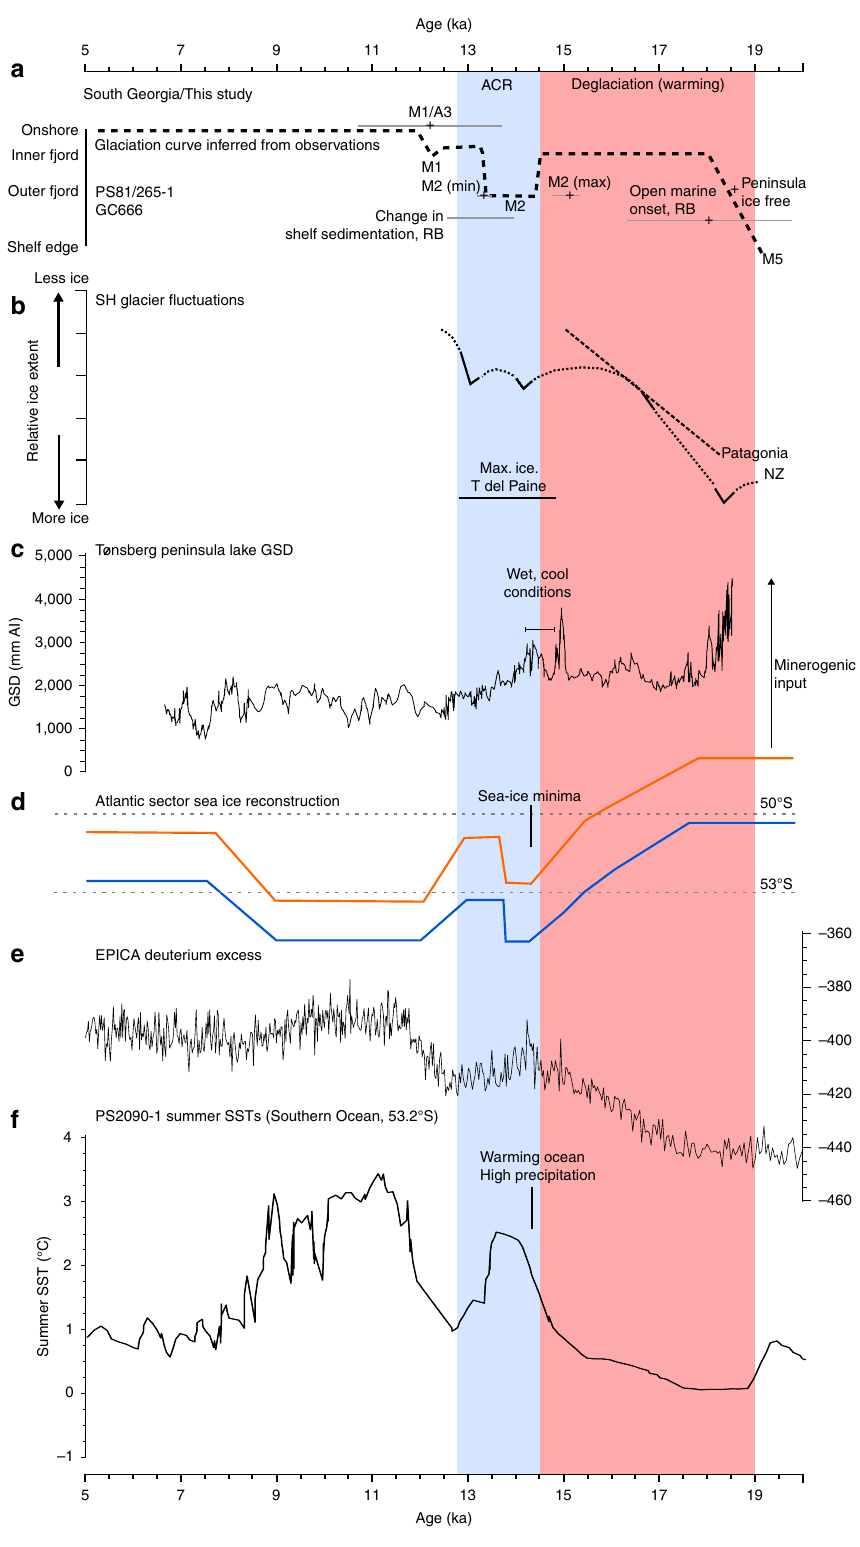
Figure 8 | South Georgia glacial history compared against published Southern Hemisphere glacial and climatic records. ( a ) Age constraints for events during the last deglaciation and termination on South Georgia from this study and published records, and a new glaciation curve inferred from these observations. These events are compared with ( b ) glacier fluctuations from other Southern Hemisphere sites (refs 28,34,73), ( c ) grey-scale density (GSD) record from Tønsberg Lake, north South Georgia, as a proxy for minerogenic input (ref. 25), ( d ) reconstructions of the northern sea-ice edge (blue line) and southern boundary of the polar front (orange line) for the last deglaciation in the Atlantic sector of the Southern Ocean (ref. 75), ( e ) EPICA Dome C (EDC) Ice core Deuterium content record, and ( f ) Summer sea-surface temperature (SST) record for core PS2090-1, south of the Antarctic Polar Front (ref.